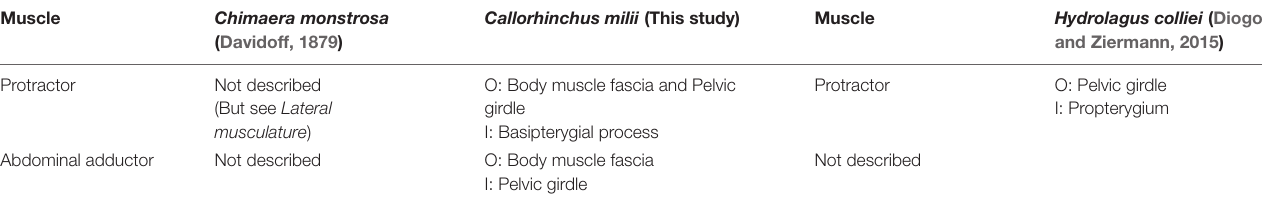
Deep dorsal layer (tiefe dorsale Schicht) TABLE 3 | Chimaeroid lateral pelvic musculature and their points of origin (O) and insertion (I).